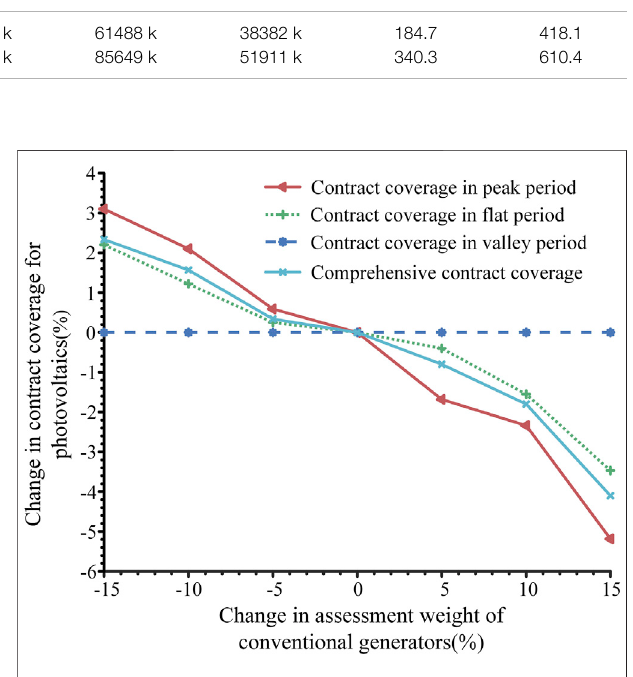
FIGURE 6 | Changes in CCR for photovoltaics under different assessment weights of the quota system.